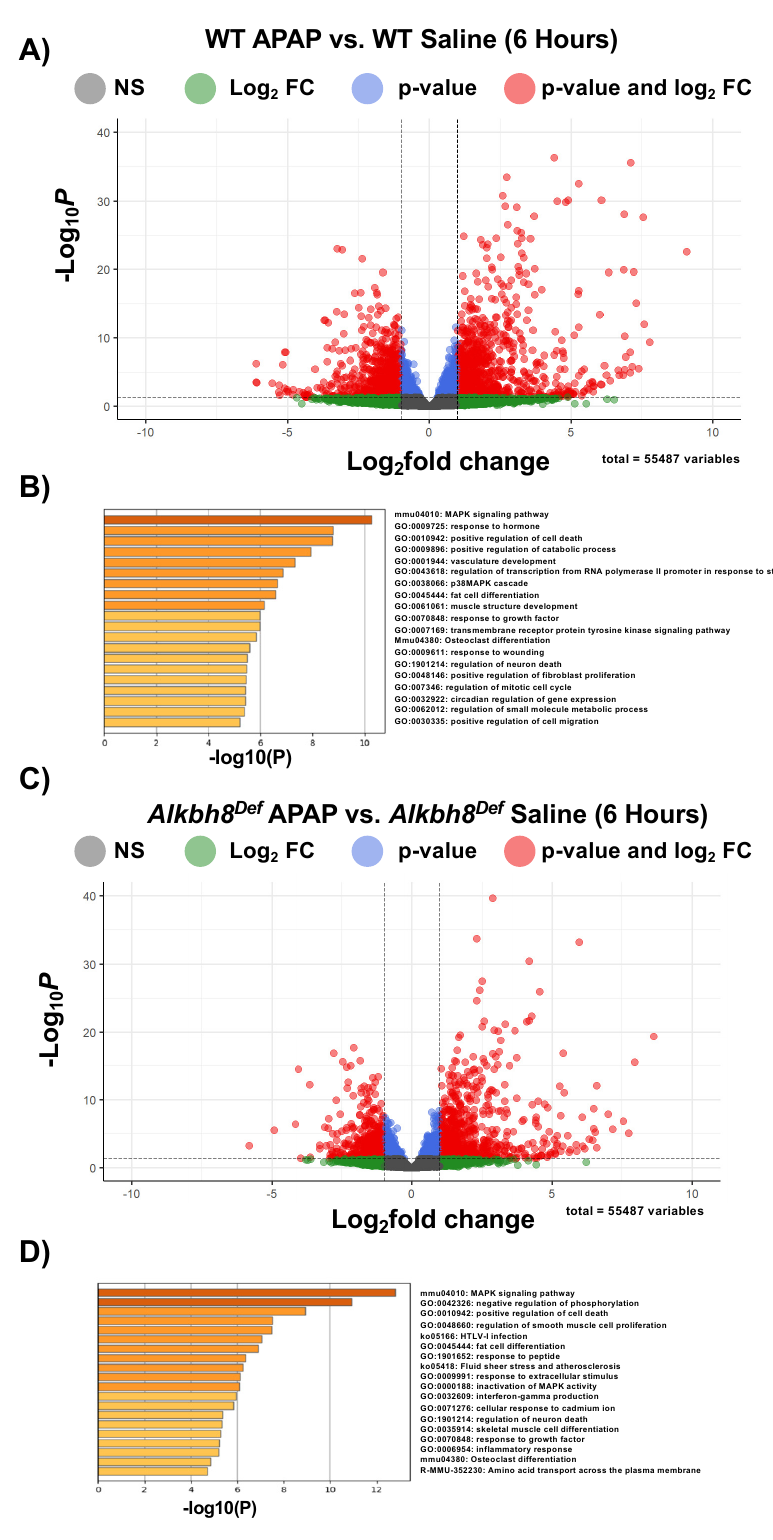
Figure 2. Next-generation mRNA sequencing analysis of the transcriptional response to APAP. WT and Alkbh8 Def mice (N = 3) were left untreated or exposed to a single dose of APAP and livers were harvested after 6 h and RNA was purified and subject to mRNA-seq. Enhanced volcano plots from mRNA-seq data were generated for each of the comparisons and metascape analysis were performed for log 2 FC > 2.0 and p adj. values ≤ 0.05 for ( A , B ) WT APAP vs. WT Saline and ( C , D ) Alkbh8 Def APAP vs. Alkbh8 Def Saline.